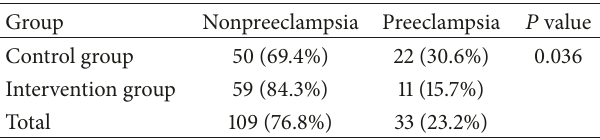
Table 3: Comparison of preeclampsia incidence between interven- tion group and control